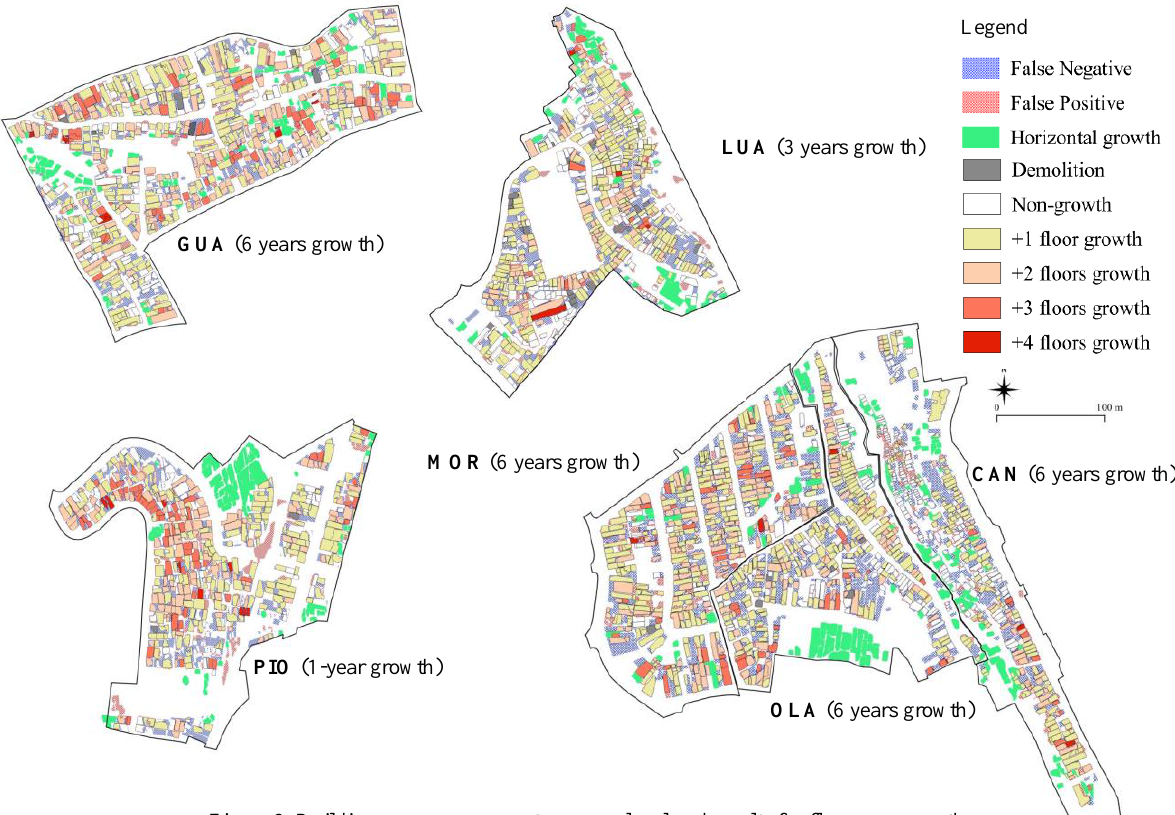
Figure 3. Building maps: assessment per-area level and results for floor area